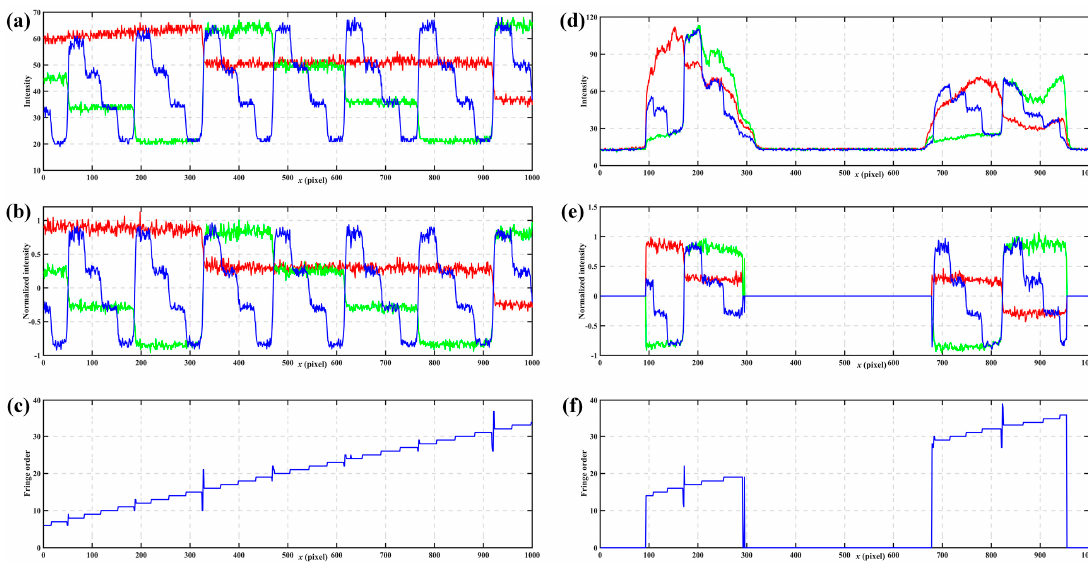
Figure 12. One cross-section of the n GL method. ( a ) n GL patterns without normalization of the reference plane, and ( b ) same patterns after normalization, ( c ) fringe orders calculated from the normalization patterns for the reference plane, ( d ) n GL patterns without normalization of the measured objects, and ( e ) same patterns after normalization, and ( f ) fringe orders calculated from the normalization patterns for the measured objects.